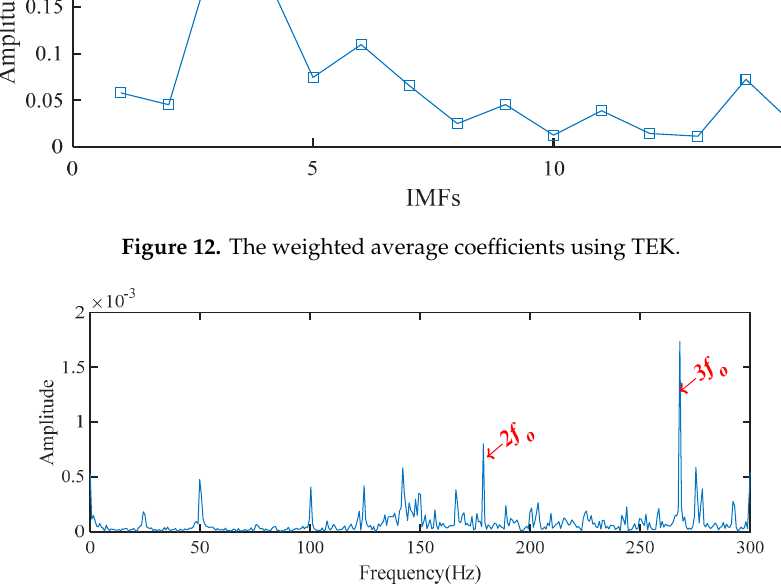
Figure 13. The spectrum of the WAEEMD filtered signal.